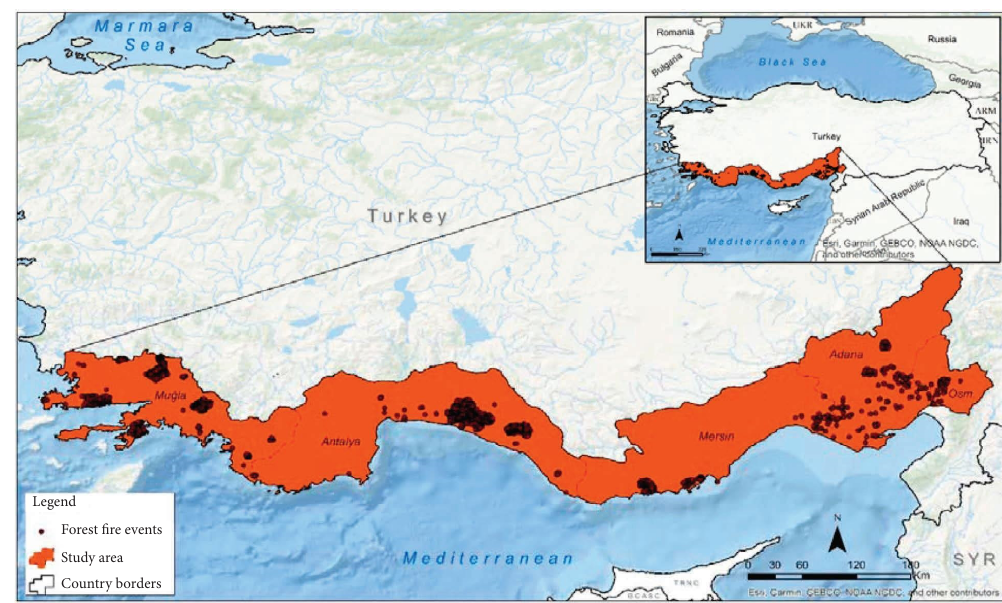
Figure 1: Location map of the study area.